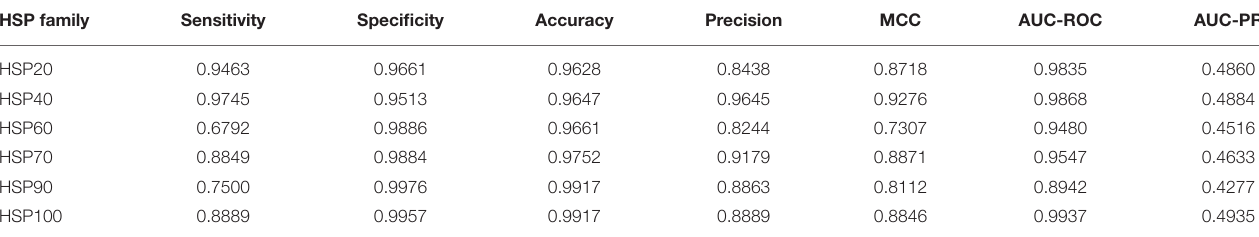
TABLE 4 | Performance metrics for the proposed approach with regard to classification of different families of